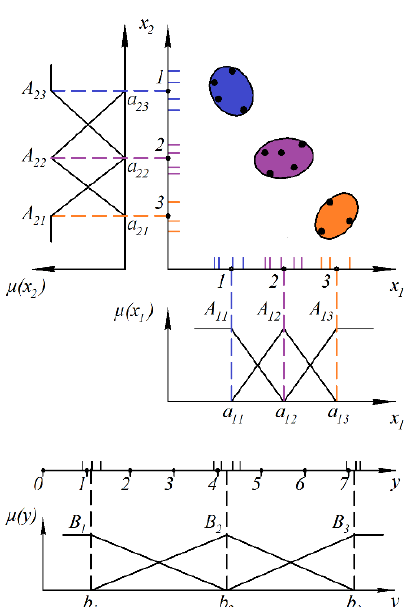
Figure 1. Example of projection of results on individual axes, cluster coordinates, and membership functions located in the centers of